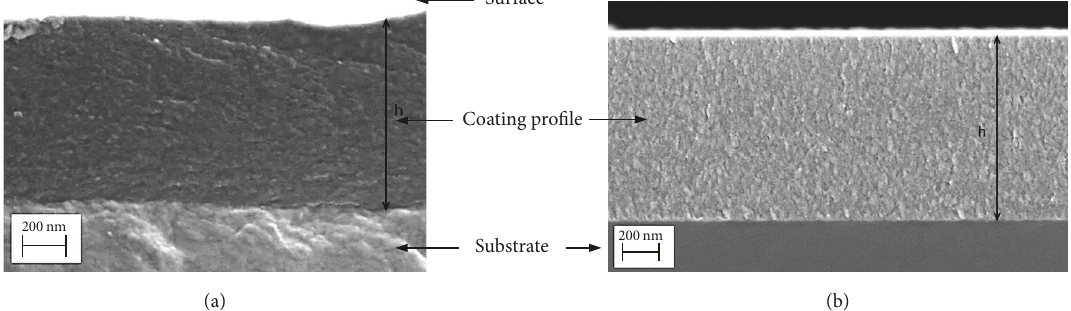
Figure 10: Cross-sectional SEM images of AlTiN coatings deposited at 400 Hz on 100Cr6-steel substrate (a) and silicon substrate (b) with film thickness ℎ = 1.023 𝜇